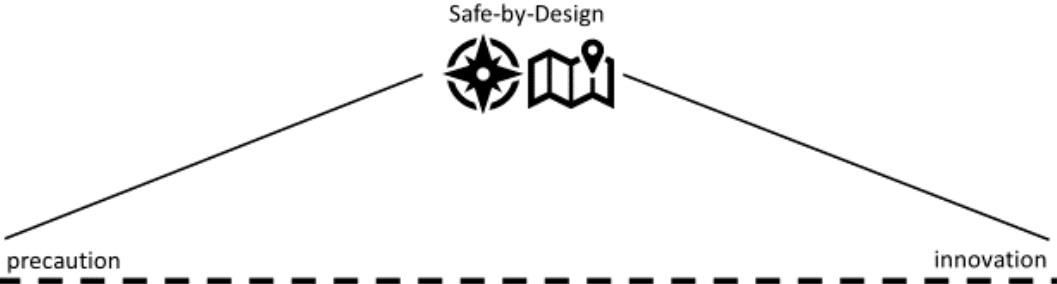
Figure 1. Navigating the Scylla of precaution and the Charybdis of innovation through